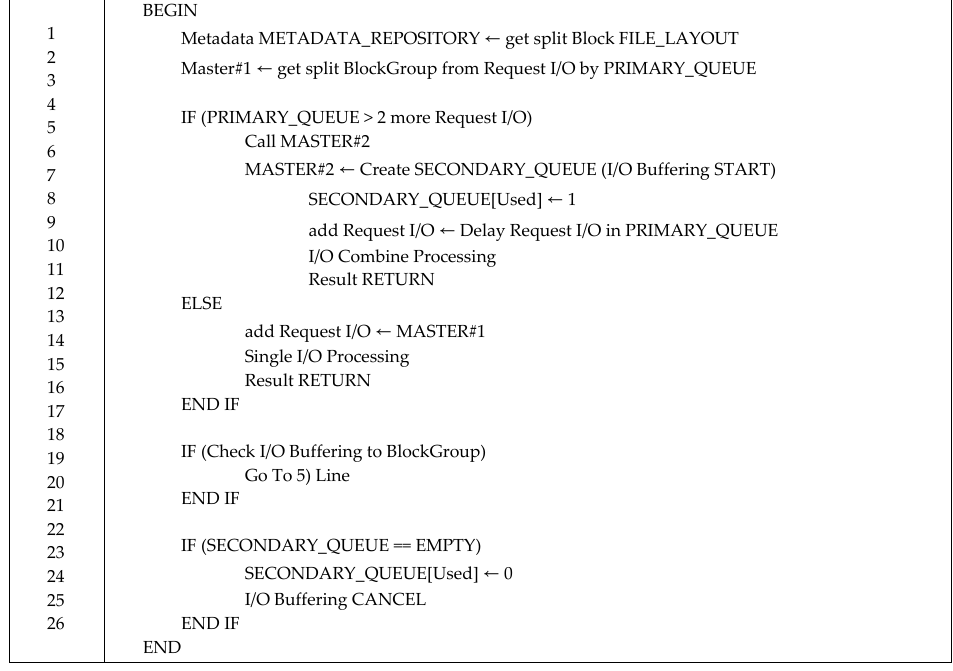
Figure 11. I/O combining algorithm.